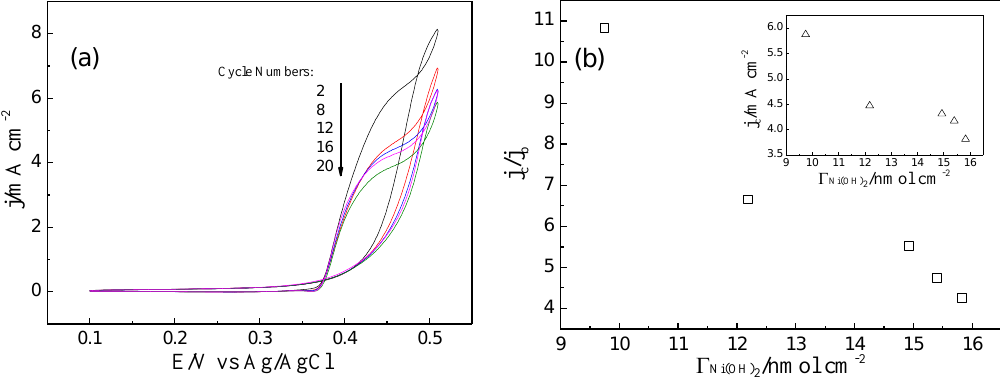
Figure 3. ( a ) Cyclic voltammograms of Ni in 1 mol L − 1 KOH in the presence of 20 mmol L − 1 glycine under di ff erent cycle numbers, ( b ) relative anodic-peak current density and anodic-peak current density (inset) as a function of nickel hydroxide loadings for glycine